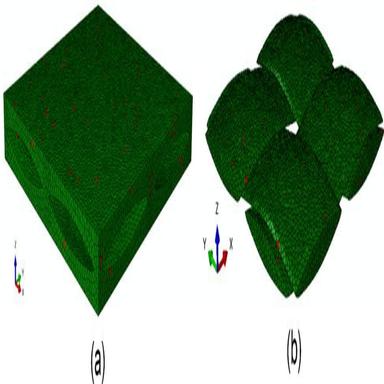
FEA model with junction area void defects: (a) Junction area; (b) FEA model of junction area void defects, (c) FEA model with 1% volume defects, (d) FEA model with 2% volume defects, (e) FEA model with 4% volume defects, (f) FEA model with 5% volume defects.